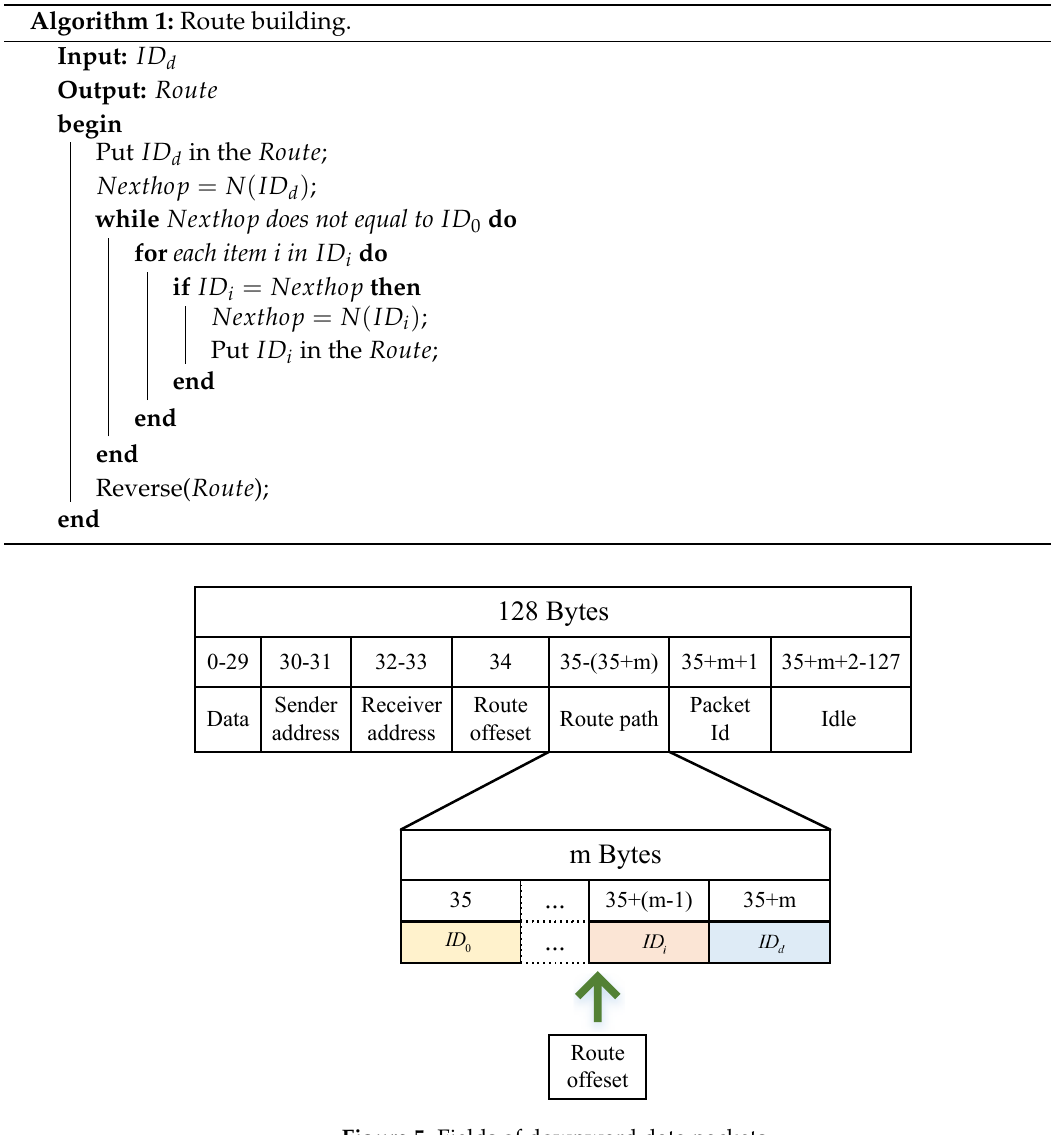
Figure 5. Fields of downward data